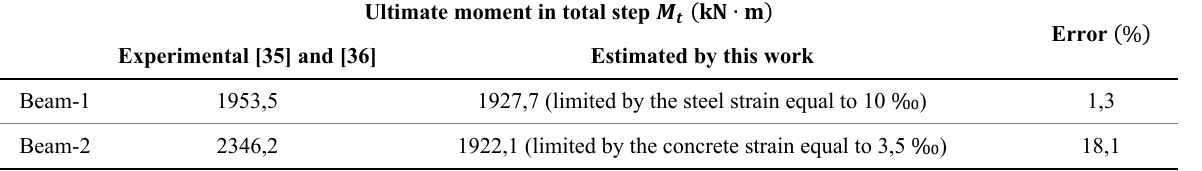
Table 2. Summary of test and estimated ultimate moment.